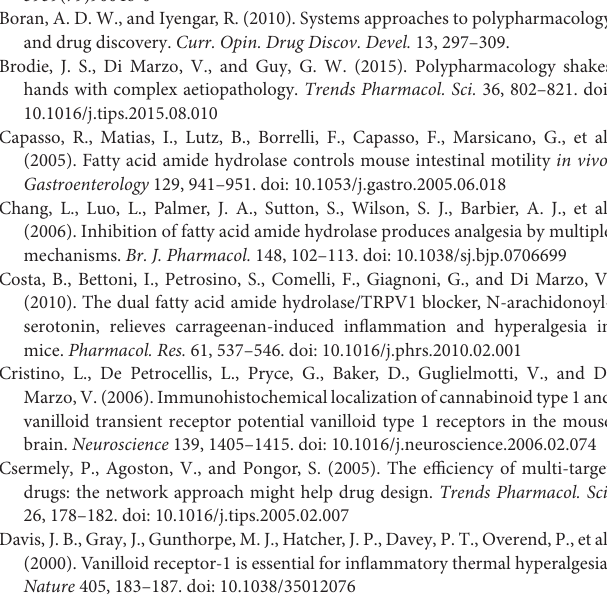
NM: preparing of the figure and table, writing of the manuscript, KS: review conception, writing of the